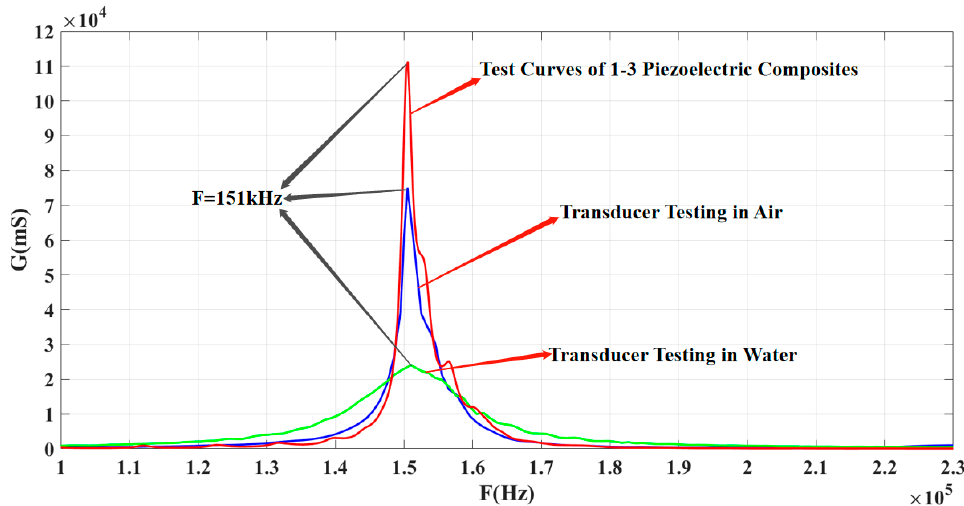
Figure 13. Conductivity G curves of the piezoelectric composite and transducer.